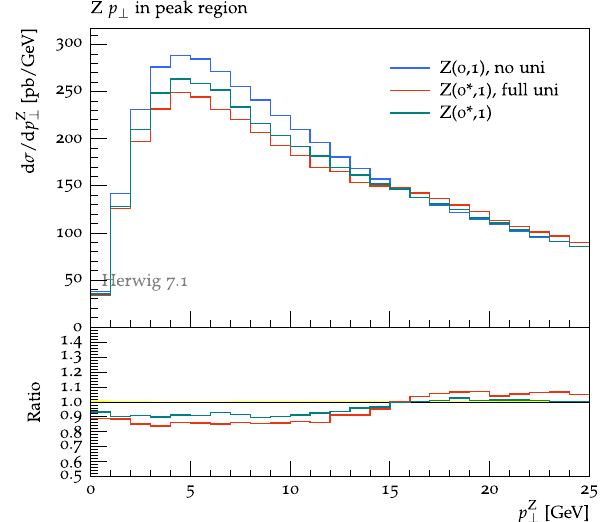
Fig. 15 As Fig. 14 we show the transverse momentum of a Z 0 -boson. Here we plot the distributions including NLO corrections to the pro- duction process. For details see